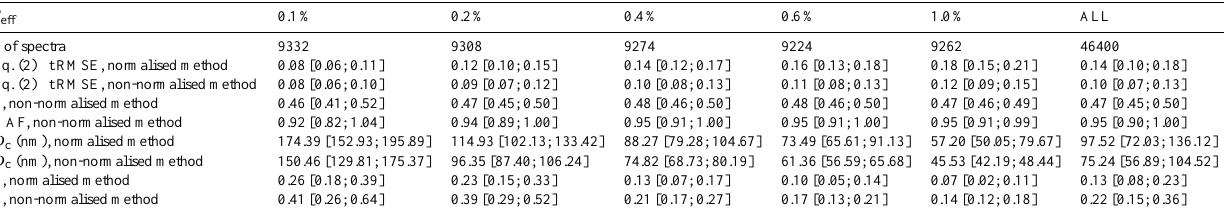
Table 1. Number of spectra, the results of the normalised and non-normalised fitting of Eq. (2), the related terms and the derived parameters of D c and κ used in this study. For parameters shown are the median values, with 25th and 75th percentile values included in the square brackets. Data shown separately for each supersaturation S eff level, as well as for the whole data set.